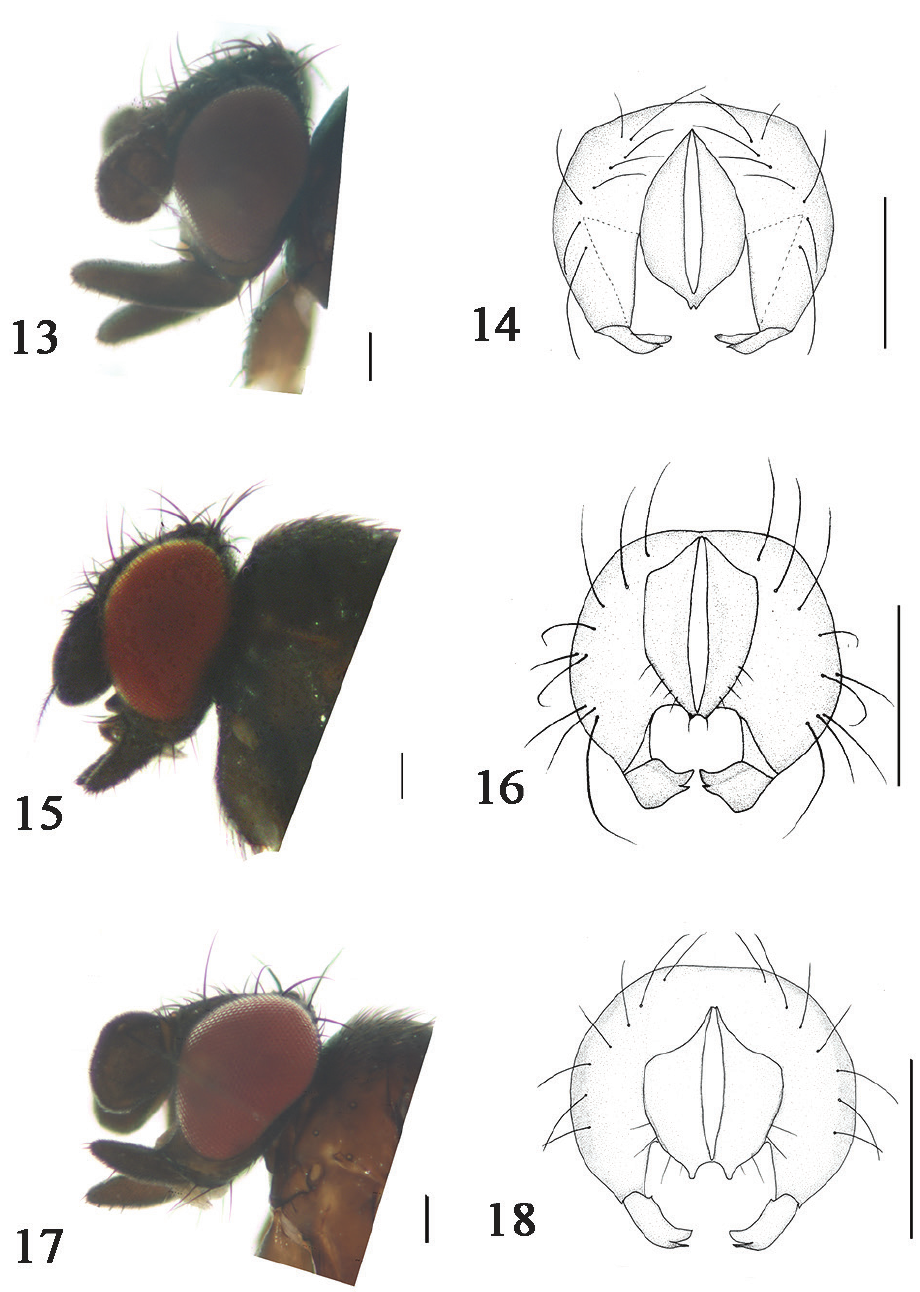
Figures 13–18. 13 Phyllomyza angustigenis Xi et Yang (male); head, lateral view 14 Phyllomyza an- gustigenis Xi et Yang (male); epandrium, cerci, and surstyli, posterior view 15 Phyllomyza claviconis Yang (male); head, lateral view 16 Phyllomyza claviconis Yang (male); epandrium, cerci, and surstyli, posterior view 17 Phyllomyza cuspigera Xi et Yang (male); head, lateral view 18 Phyllomyza cuspigera Xi et Yang (male); epandrium, cerci, and surstyli, posterior view. Scale bars: 0.1